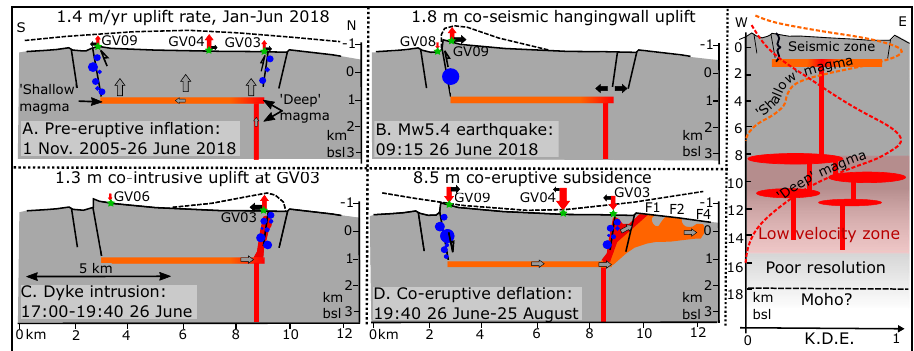
Fig. 6 Cartoon cross-sections depicting the in fl ation-de fl ation cycle of the 2018 eruption and plumbing system at Sierra Negra. A Pre-eruptive in fl ation. B Mw5.4 earthquake. C Dyke intrusion. D Co-eruptive de fl ation, including schematic vertical (red arrows) and horizontal (black arrows) displacements of cGPS stations (green stars), earthquake hypocentres (blue circles), and possible geometry of magma plumbing system (orange for shallow equilibrated magmas, red for deep equilibrated magmas). Black dashed line provides a schematic illustration of relative change in surface shape during each interval. E Deeper magma plumbing system. Dashed lines indicate normalized kernel density estimates ( “ Methods ” ) of equilibration depths for early (deep-red) and late (shallow-orange) erupted